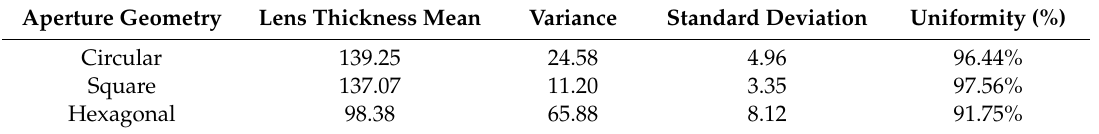
Table 4. Uniformity of fabricated MLAs derived from measured lens thickness.